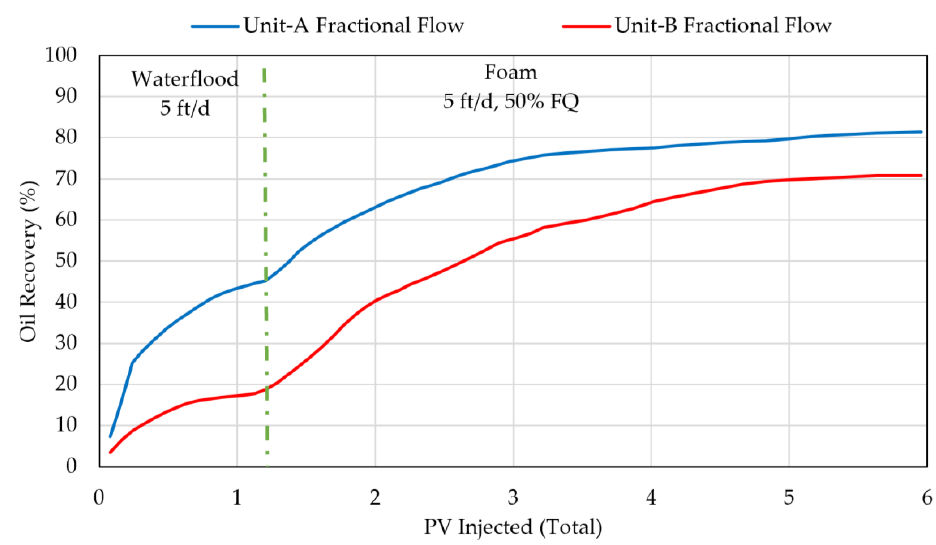
Figure 16. Oil recovery (%) from Unit-A and Unit-B cores for DI-Exp 3.